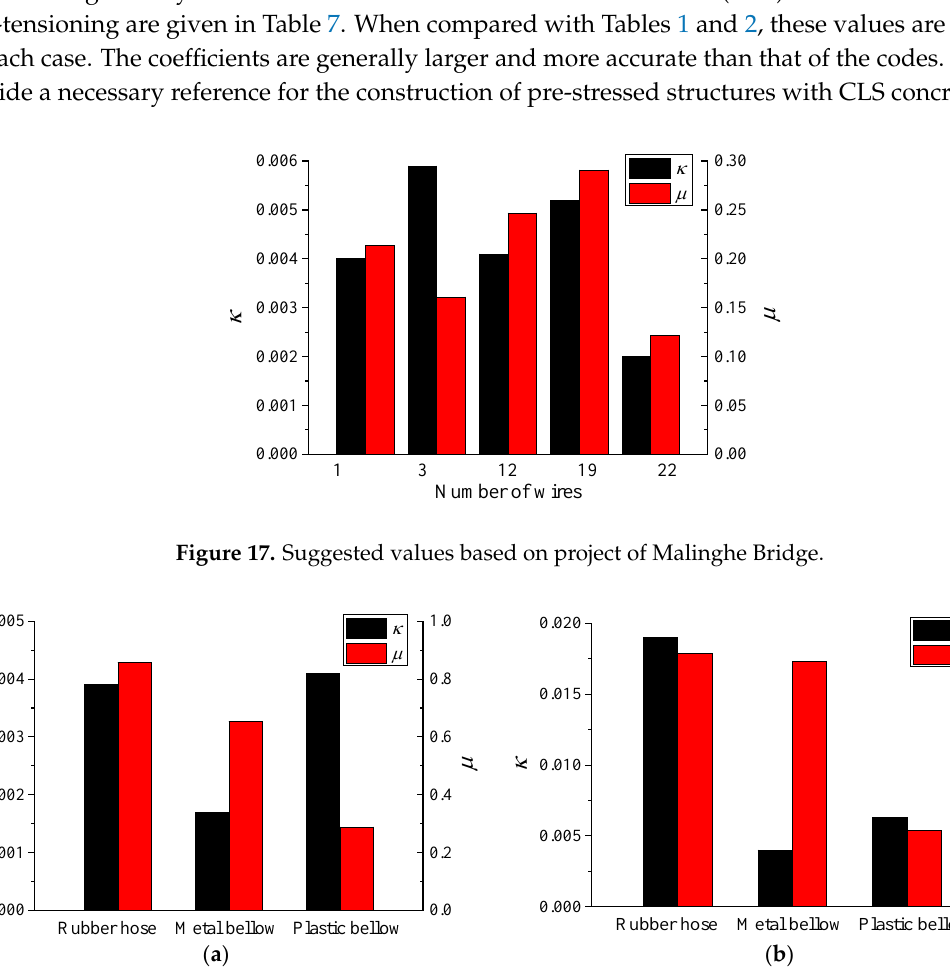
Figure 18. Suggested values based on project of Wujiang Bridge: ( a ) 1 wire; and ( b ) 19 wires. Table 7. Suggested values for CLS concrete at each case.